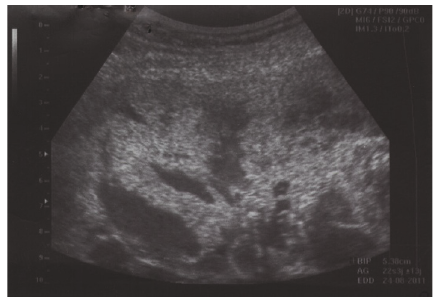
Figure 1: Ultrasonography appearance of a lacunary placenta.